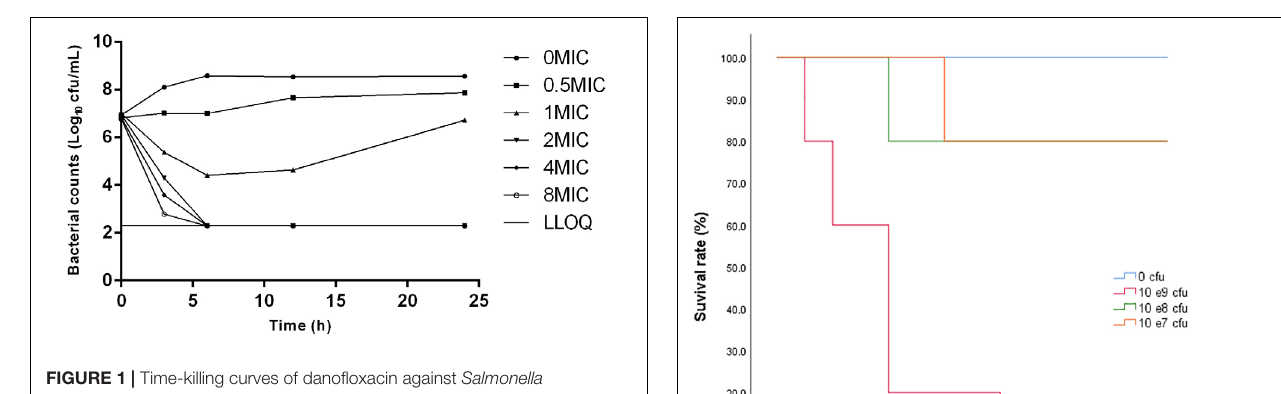
FIGURE 1 | Time-killing curves of danofloxacin against Salmonella typhimurium in Mueller-Hinton (MH) broth with concentrations of danoflocaxin between 0 and 8 × the minimum inhibitory concentration (MIC).